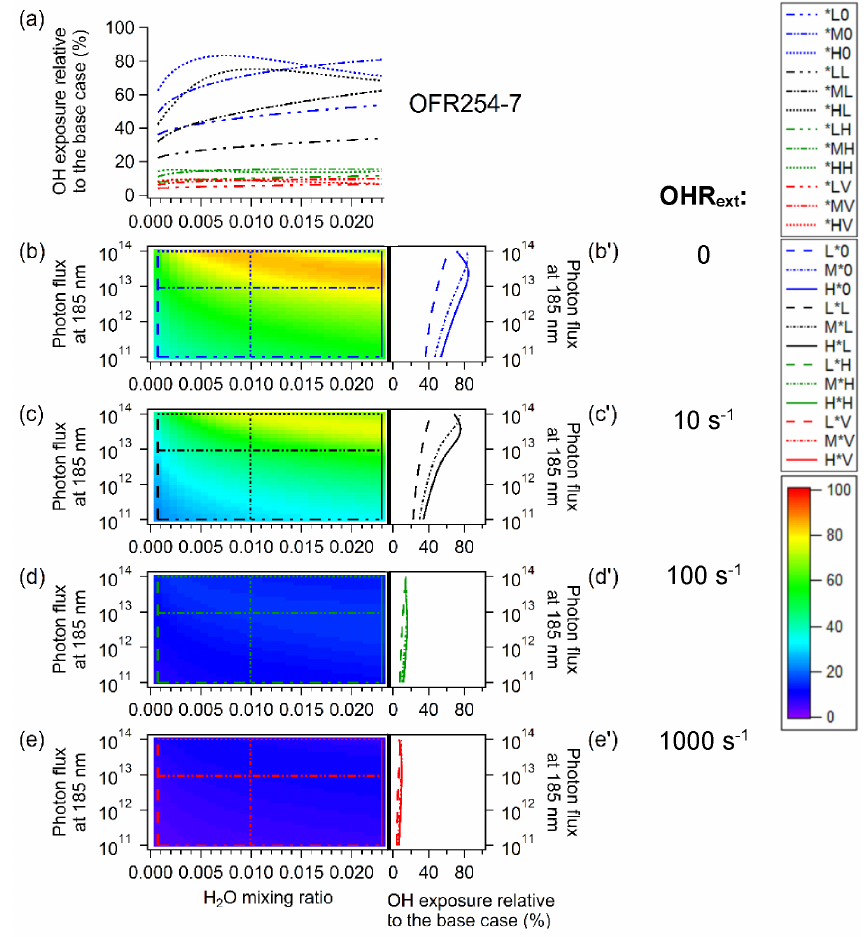
Figure 8. Percentage of OH exposure in OFR254-7 to the base case (OFR254-70) vs. the same parameters and in the same format as Fig. 2f–j, g (cid:48) –j (cid:48)